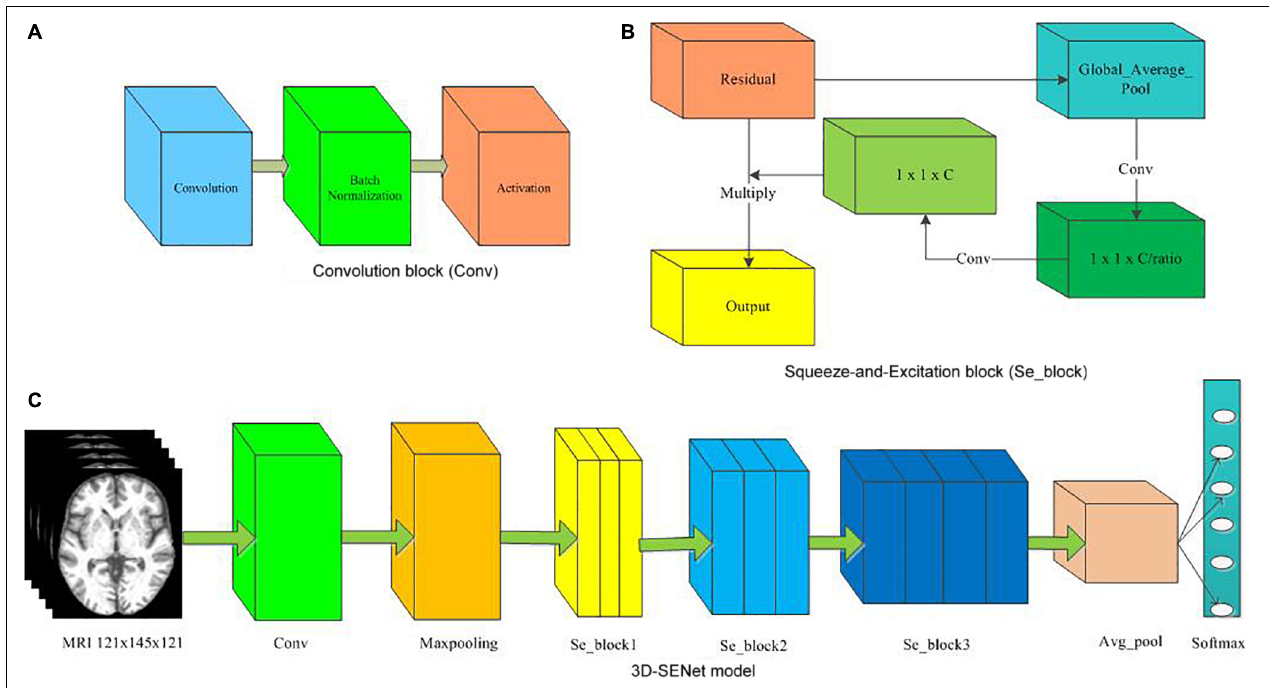
FIGURE 7 | The architecture of the 3D-SENet model. (A) Convolution block (Conv), (B) Squeeze-and-Excitation block (Se_block), (C) 3D-SENet model.